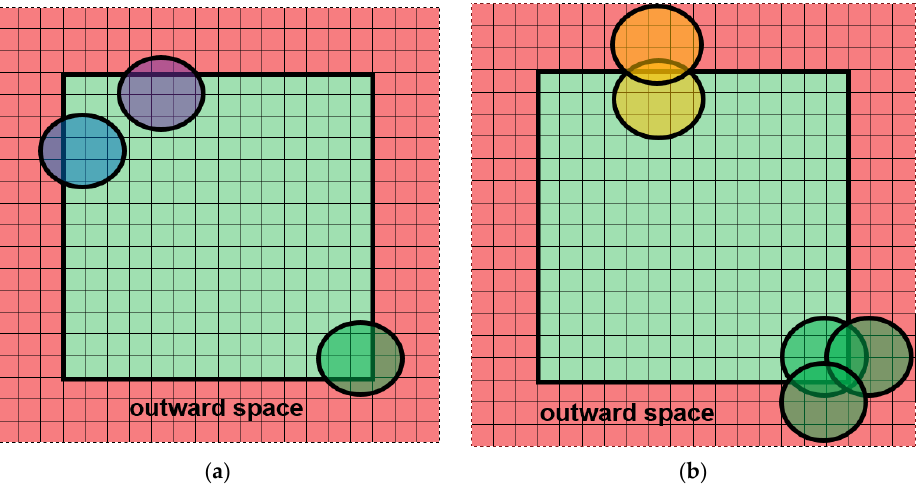
Figure 3. Semi-open boundary conditions: ( a ) growing grains go outside the space, ( b ) grains inside the modeling space.